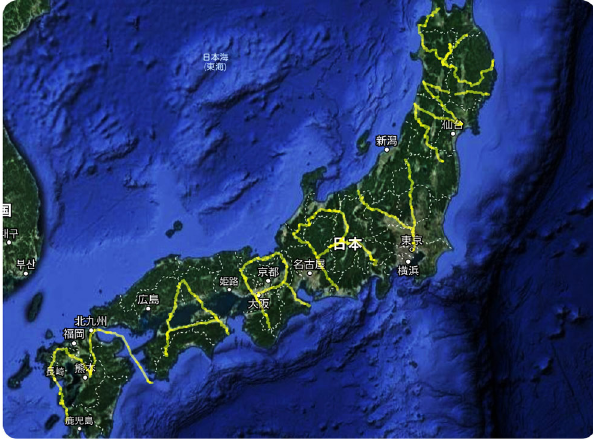
Fig. 2 The largest GPS drawing recognized by the Guinness Book of World Records